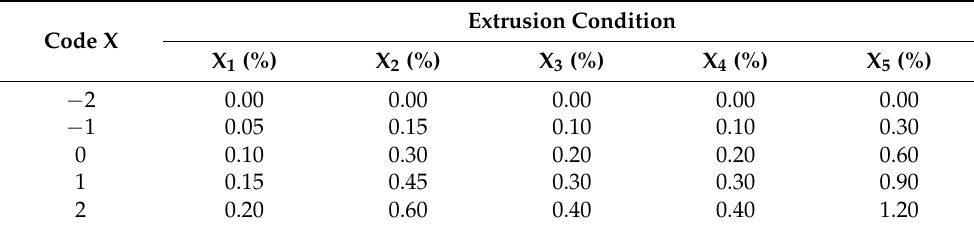
Table 1. Codes and levels of